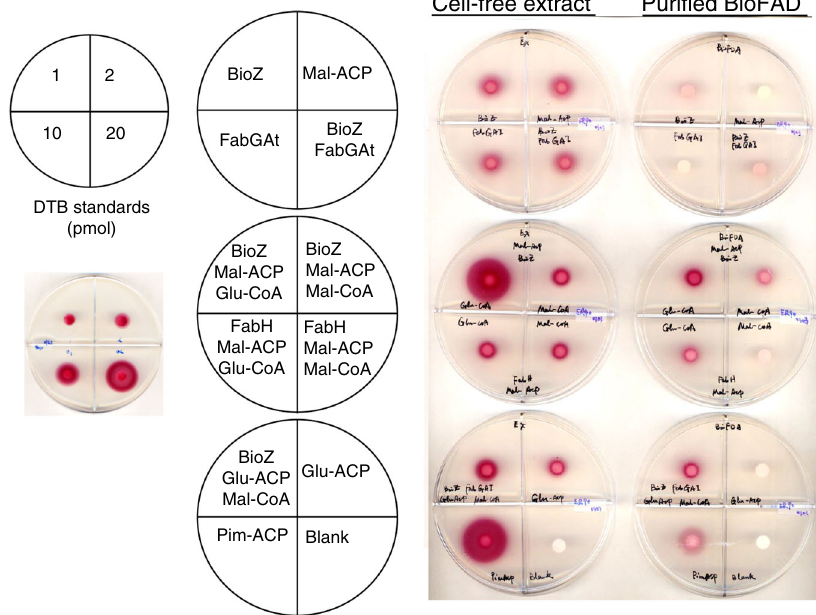
Fig. 6 Functional replacement of E. coli BioC and BioH with AtBioZ in vitro. The preparations tested were either a fractionated and dialyzed extract of the E. coli Δ bioC Δ bioH strain STL25 or a mixture of puri fi ed E. coli DTB synthesis proteins, BioF, BioA, and BioD as depicted above the plates. The components in each of the reactions applied to the bioassay plates are given in the plate depictions to the left of the cell-free extract assays. The contents of the reactions containing BioF, BioA, and BioD and their substrates are given to the right of those assay plates. Response to DTB standards is given in the box on left side of the fi gure. The top plates contain controls. In a more-de fi ned assay, we reconstituted DTB synthesis in vitro using BioZ proteins and the puri fi ed E. coli biotin ring synthesis enzymes, BioF, BioA, and BioD, plus the substrates required for their reactions. As puri fi ed BioB is inactive under aerobic conditions, it was omitted and thus the assayed product was DTB. Although the DTB production was low owing to the weak activity of the puri fi ed BioD and the relative insensitivity of DTB bioassay ( fi ve to sixfold less sensitive than is the biotin bioassay) these results showed that BioZ proteins use glutaryl-CoA and malonyl-ACP as substrates to synthesize the pimeloyl-ACP required for DTB synthesis. To a much lesser extent, the combination of glutaryl-ACP and malonyl-CoA was also active (Fig.